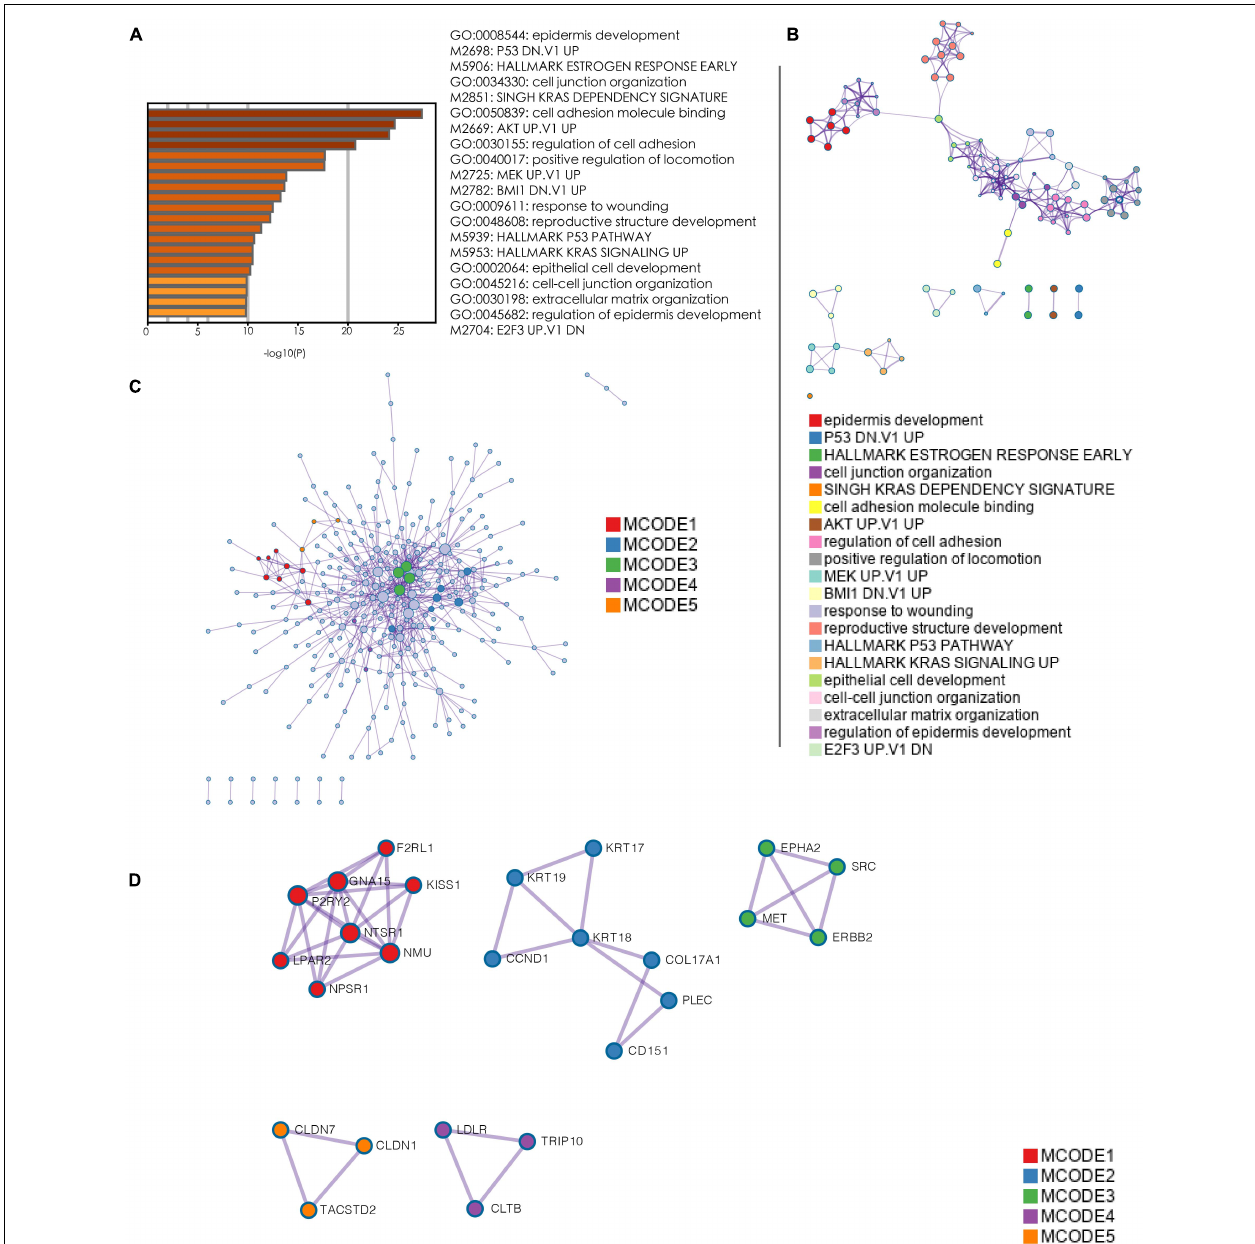
FIGURE 5 | Enrichment analysis and hub gene selection. (A) Bar plot depicting the results of an enrichment analysis of genes in the blue module. (B) Interaction network with enrichment terms. (C) Protein–protein interaction networks for genes generated using MCODE. (D) Five key protein–protein interaction networks identified using MCODE. (MCODE: molecular complex